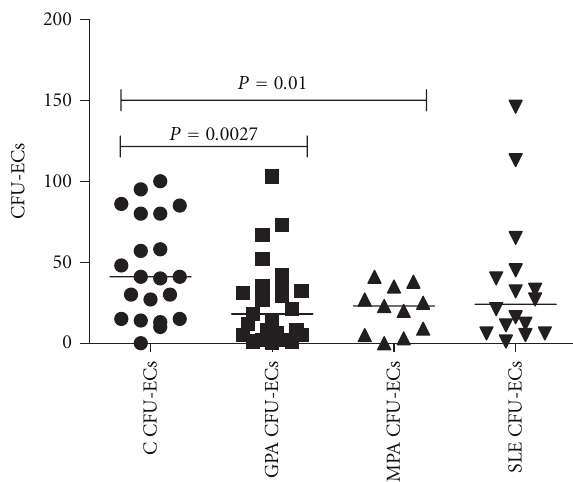
Figure 2: Proliferative activity of peripheral circulating eEOCs in GPA, MPA, and SLE. Patients with either GPA or MPA showed significantly less eEOC proliferation (defined as smaller numbers of colony unit endothelial cells [CFU-ECs]) than controls (bars show median). SLE patients were not di ff erent from controls. In GPA the numbers of colonies did not correlate with clinical activity of the disease as represented by BVAS (not